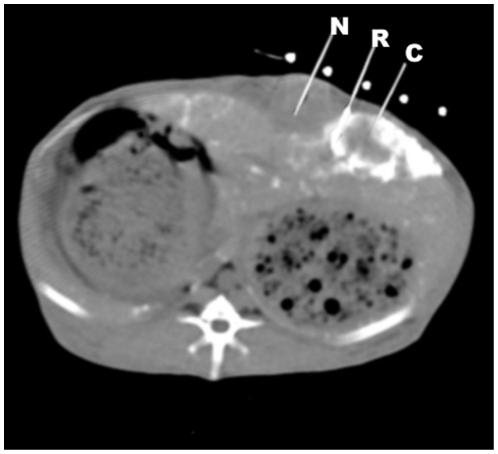
CT-guided percutaneous puncture to monitor temperature
changes.Under CT-guided percutaneous puncture, implantation of three 18G puncture
needles and replacement of FISO probes using the coaxial method were
performed. The probes were located in the core (C), rim (R), and NHP (N)
1 cm away from the rim to monitor temperature changes in real-time, and
the animals were subsequently transferred to AMF for hyperthermia.